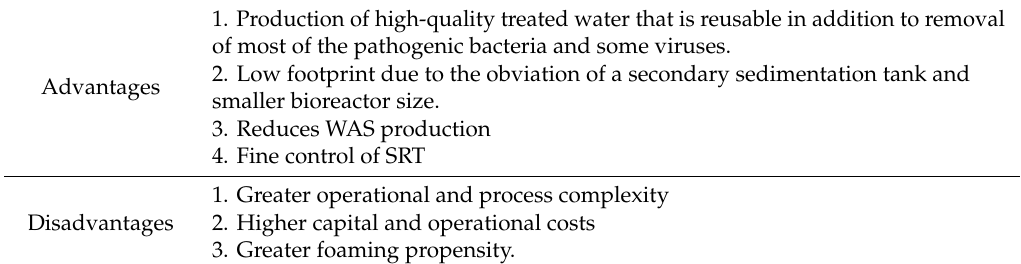
Table 1. Advantages and disadvantages of MBR over CAS; adapted from